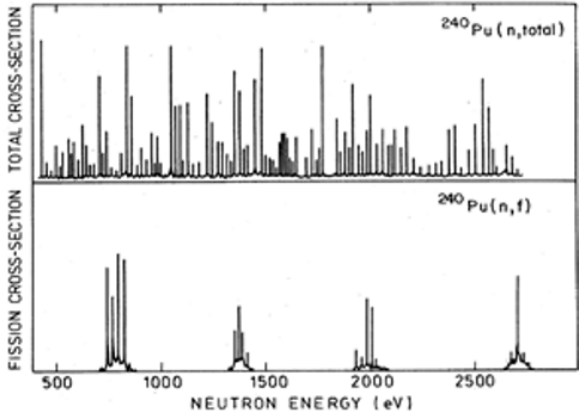
Figure 3. The total 240 Pu(n,total) neutron capture cross sec- tion measured by Kolar and Böckho ↵ [9] (upper panel) and the 240 Pu(n,f) cross section measured by Migneco and Theobald [10] (lower panel) are plotted as a function of neutron energy. Note that the fission cross section is strongly enhanced for reso- nances near Class II states in the second well. The figure is taken from Ref.